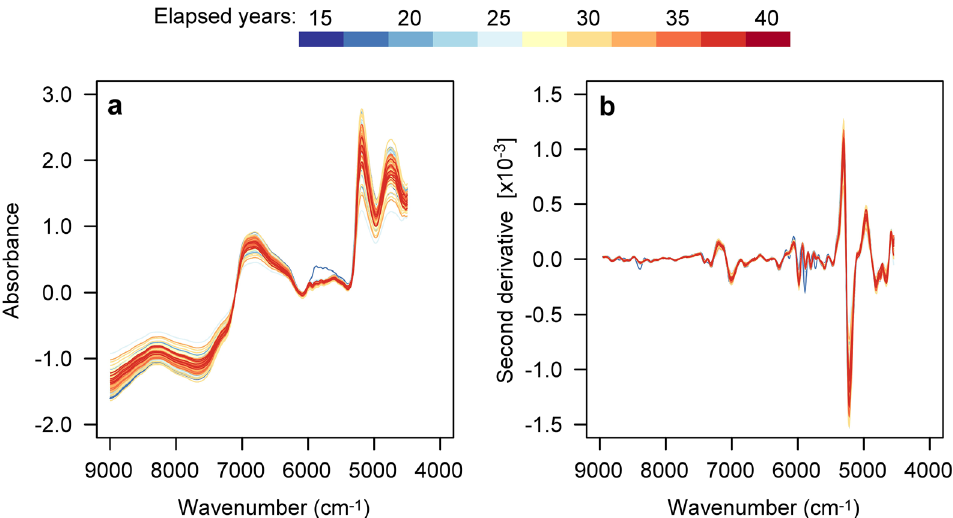
Fig. 1 Variation of ( a ) the diffuse reflectance near-infrared (NIR) spectra and ( b ) their second derivative spectra with respect to the elapsed years since wood formation in hinoki cypress ( Chamaecyparis obtusa ). The colors of the lines change from blue to red with an increase in elapsed